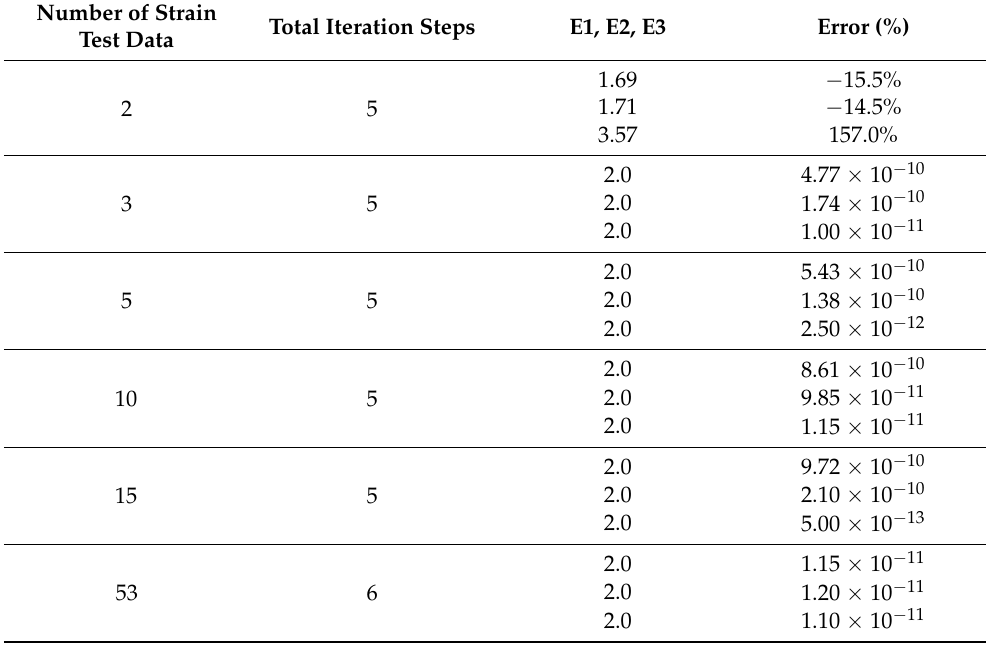
numerical simulation. The calculation results are shown in Table 5 (the convergence pro-